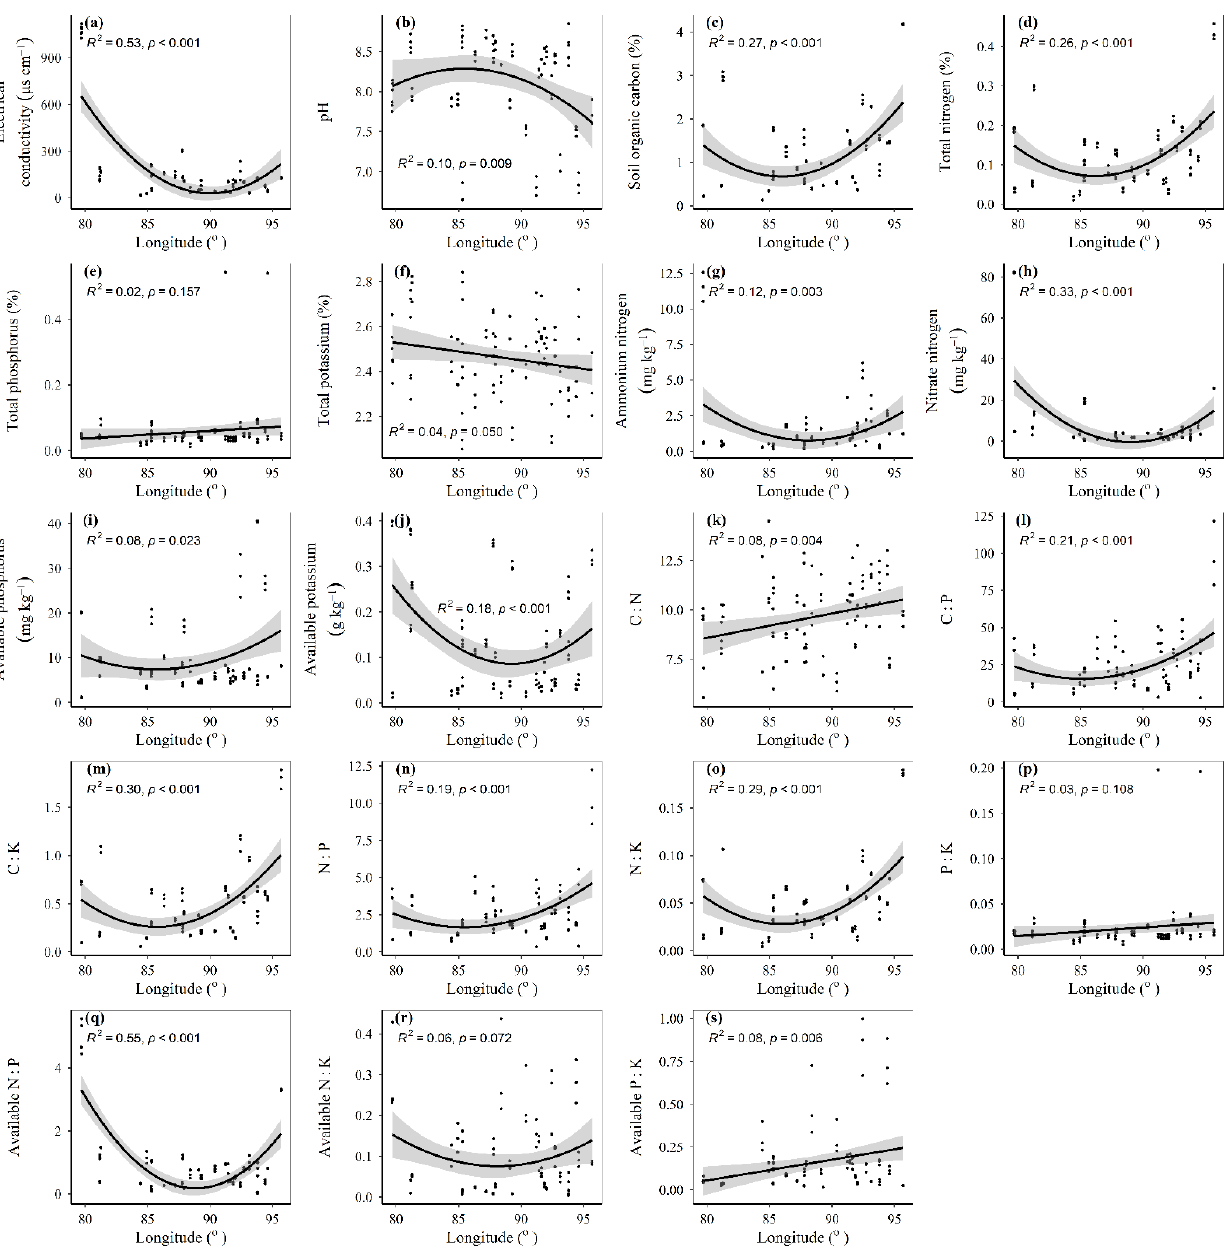
Figure A6. Relationships of longitude with soil ( a ) electrical conductivity, ( b ) pH, ( c ) soil organic carbon (SOC), ( d ) total nitrogen (TN), ( e ) total phosphorus (TP), ( f ) total potassium (TK), ( g ) ammonium nitrogen (NH 4+ -N), ( h ) nitrate nitrogen (NO 3 − -N), ( i ) available phosphorus (AP), ( j ) available potassium (AK), ( k ) ratio of SOC to TN (C:N), ( l ) ratio of SOC to TP (C:P), ( m ) ratio of SOC to TK (C:K), ( n ) ratio of TN to TP (N:P), ( o ) ratio of TN to TK (N:K), ( p ) ratio of TP to TK (P:K), ( q ) ratio of available nitrogen to AP (available N:P), ( r ) ratio of available nitrogen to AK (available N:K) and ( s ) ratio of AP to AK (available P:K) at a depth of 0–10 cm.